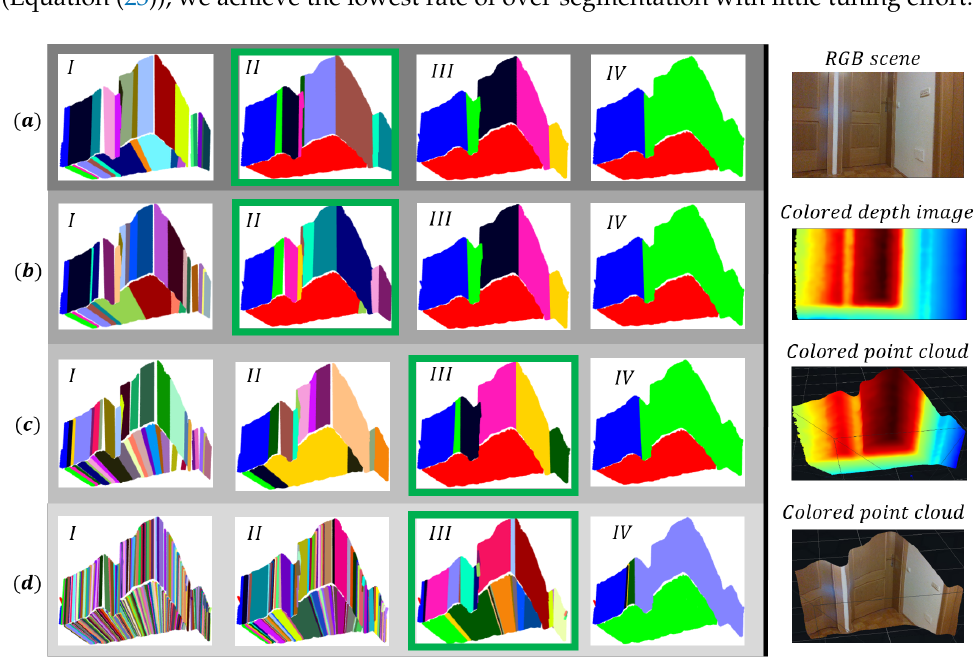
Figure 20. Clustering results for different forms of clustering criteria ( a – d ) and different values of k max for each scene, as presented in Table 2. The best segmentation results are marked with a green rectangle, where k max is set optimally. In this case, we still successfully detect flat surfaces but avoid incorrect